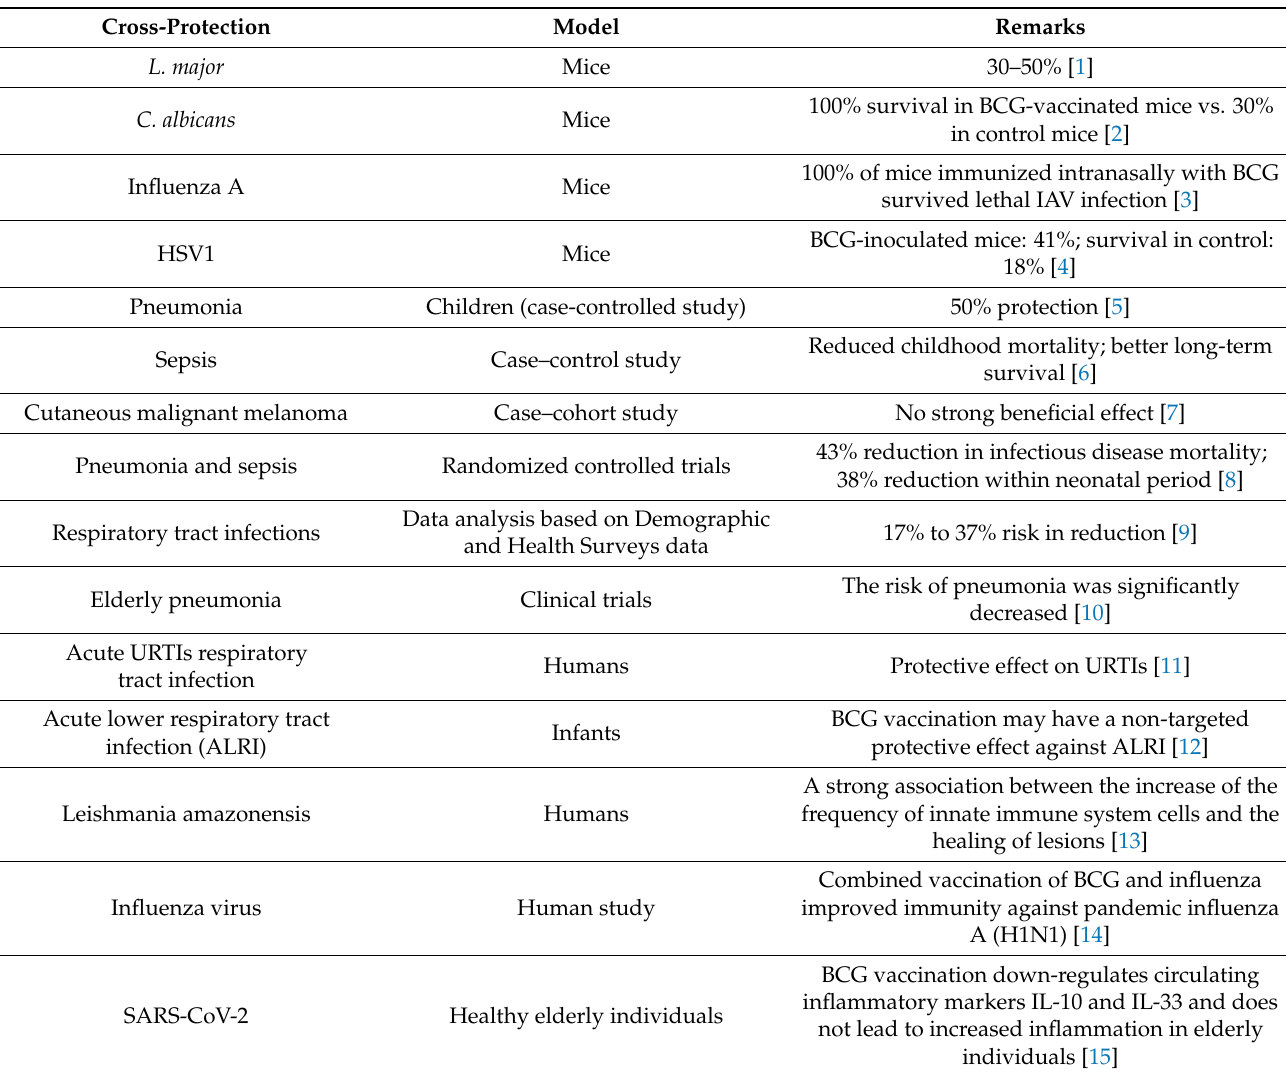
Table 1. Studies on the non-specific effects of BCG vaccination on various